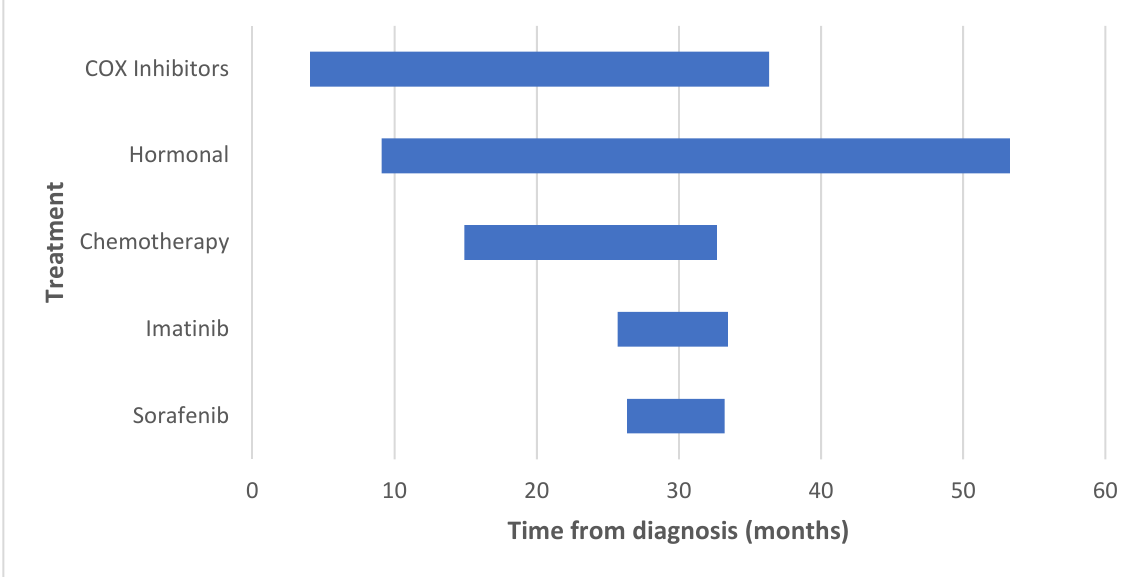
Figure 1. Two-year progression free survival according to different treatment modalities. Table 3. Prevalence, duration, and outcome of the different treatment modalities.